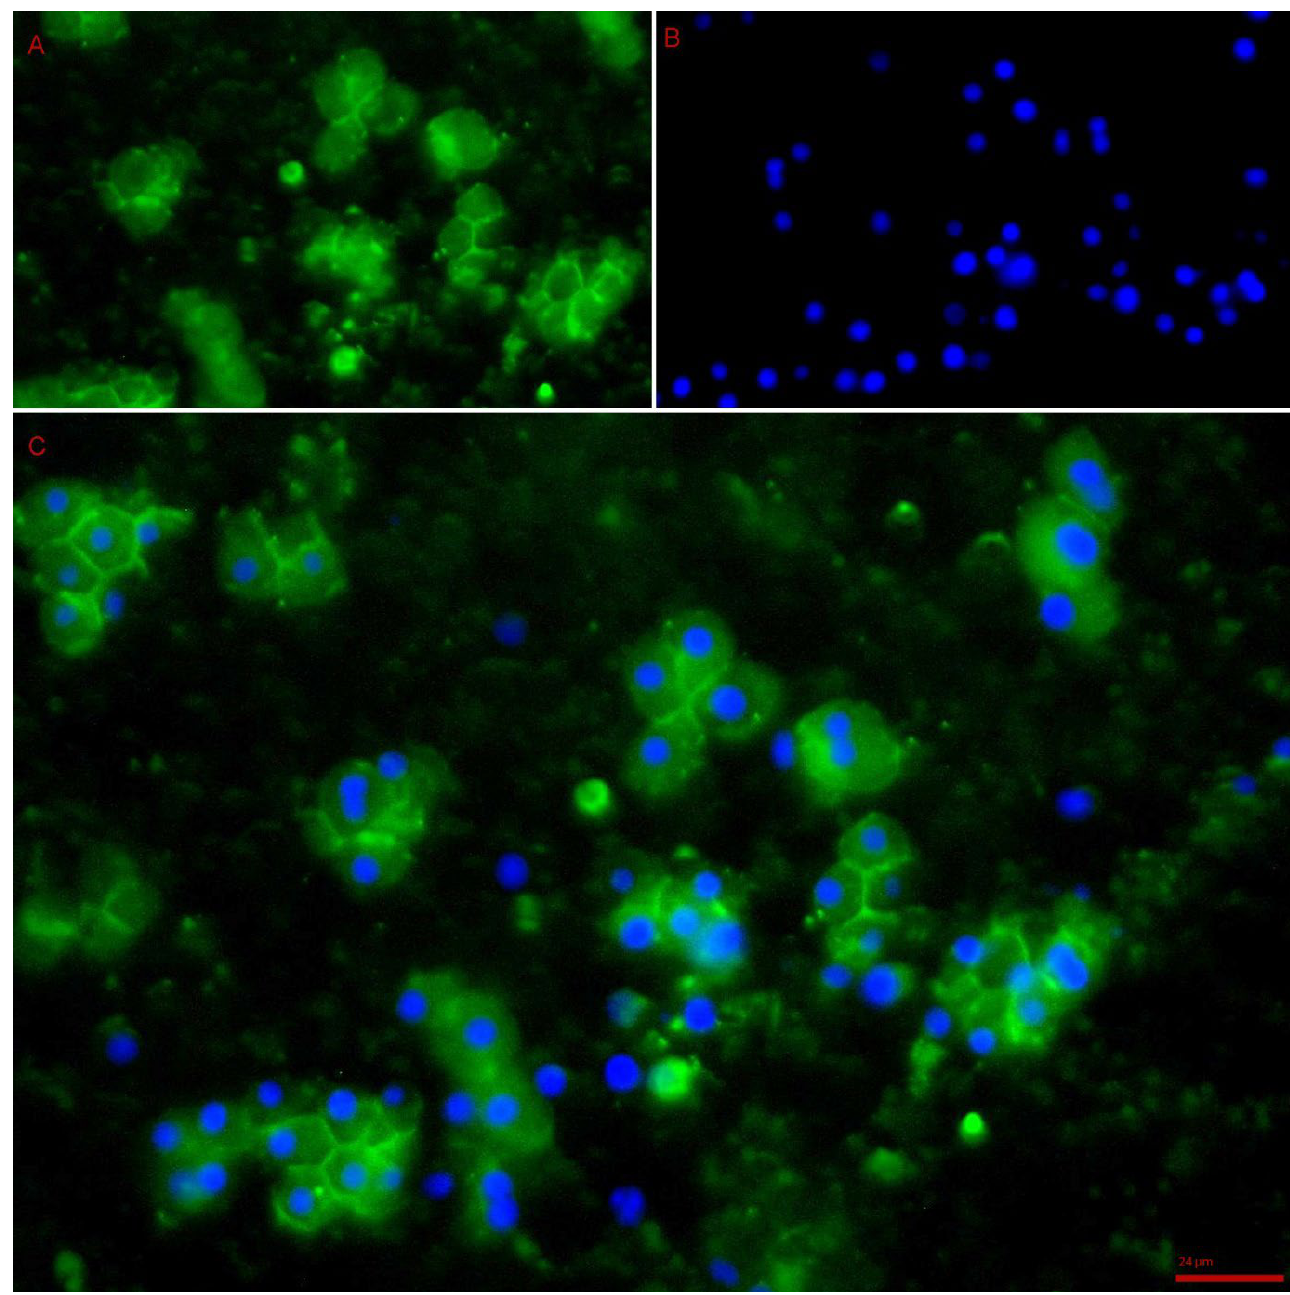
Figure 6. Phalloidin/DAPI stain 7 days post culture revealing clusters of live cells with preserved cytoskeleton. Blue: live cell nuclei; green: cytoskeleton of hepatocytes. ( A ) Green fluorescence showing the cytoskeleton of the hepatocytes, revealing intact cytoskeleton network and clumped group of cells at 7 days post culture. ( B ) Blue fluorescence revealing nuclei of live hepatocytes. ( C ) Combined fluorescence of the superimposed nuclei and cytoskeletal staining, revealing live cells clumped together at 7 days post culture while preserving their skeletal integrity. The cells seem to conform to a 3D structure and are bound to a natural matrix evident on the phalloidin/DAPI stain- ing. (40× Zoom EVOS microscopy).